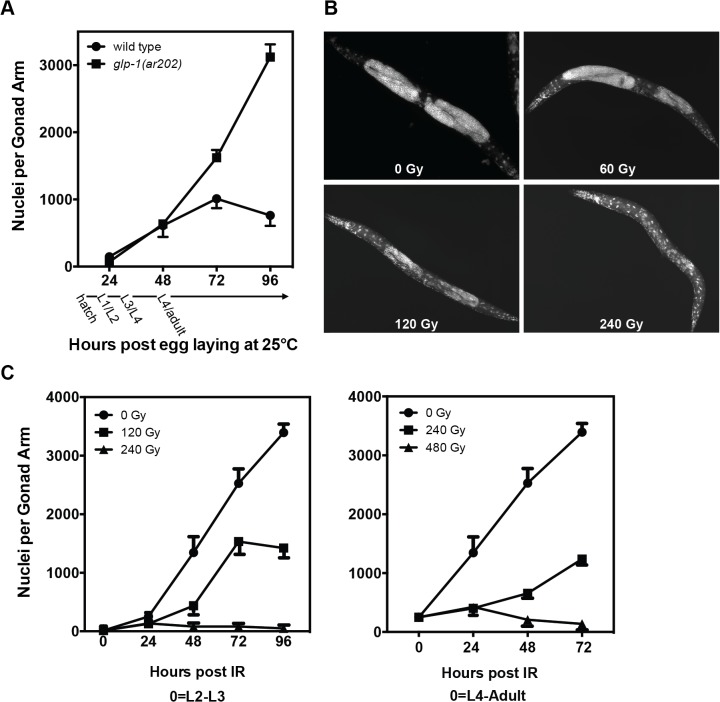
Response of C. elegans germline tumors to ionizing radiation.(A) Time course of germ cell accumulation in wild-type and glp-1(ar202) hermaphrodites. Worms were stained with DAPI at the indicated times after egg laying and imaged (20x magnification). Data (mean±s.e.m) represent number of germ nuclei⁄gonad in a minimum of 10 gonad arms. (B) Representative images of germline tumors in adult glp-1(ar202) post radiation. Worms were irradiated at the L2-L3 stage (30h after egg laying) and DAPI stained at 40h post irradiation. (C) Stage sensitivity of germline tumors to ionizing radiation. glp-1(ar202) were irradiated at the L2-L3 or late L4 stage, and quantified as in (A). All experiments were performed at 25°C as described in Methods.